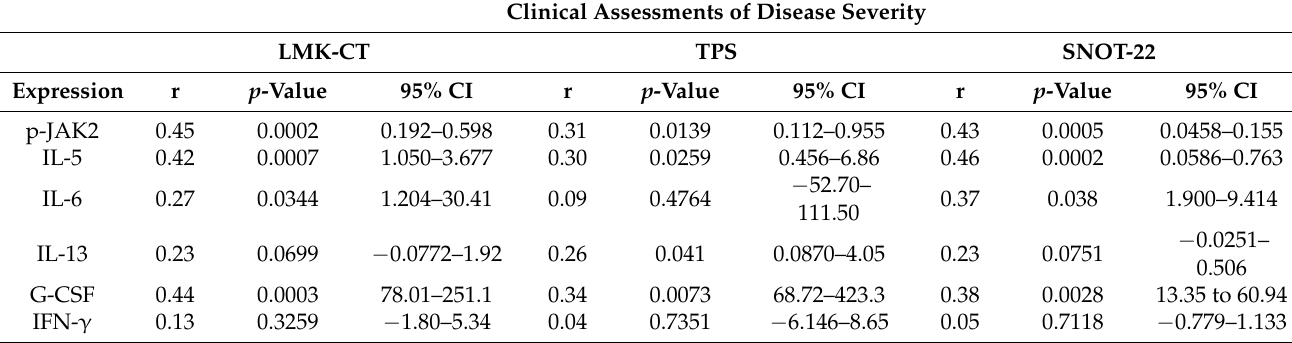
Table 4. Linear regression analyses with Pearson correlation coefficients comparing p-JAK2 or its associated cytokines and clinical measures of disease severity in